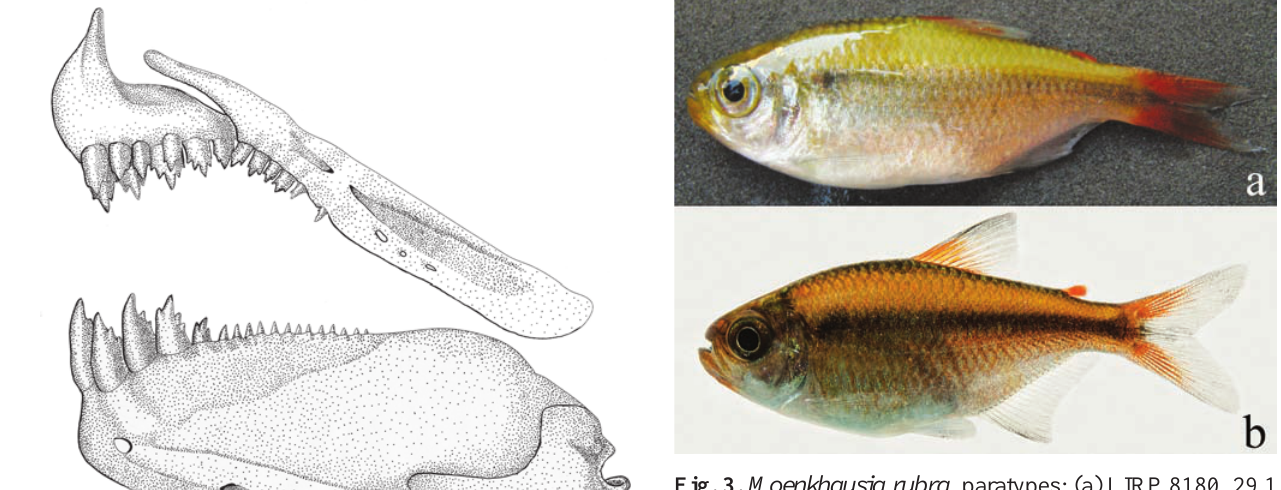
Fig. 3. Moenkhausia rubra , paratypes: (a) LIRP 8180, 29.1 mm SL, Brazil, Mato Grosso, Sapezal, rio Juruena, immediately after capture; (b) MZUSP 114032, 39.8 mm SL, Brazil, Mato Grosso, Campos de Júlio, rio Juína, immediately after capture. fins intense orange to reddish, except for distal hyaline portion on dorsal and caudal fins.